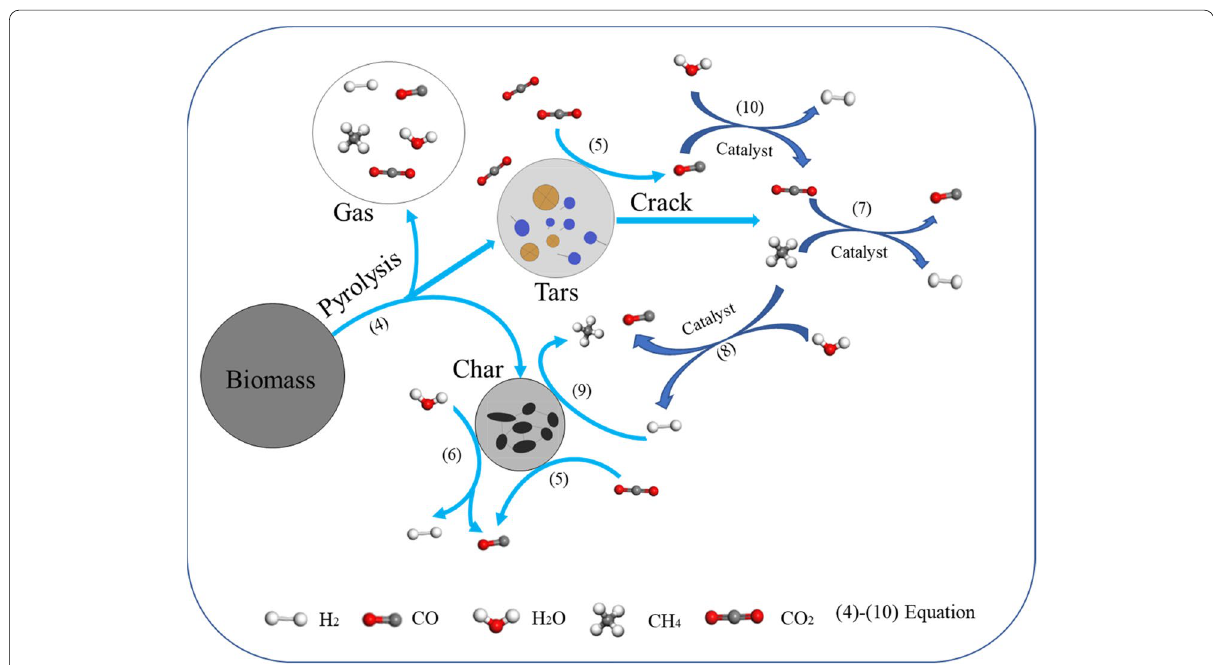
Fig. 8 Supercritical carbon dioxide gasification mechanism of